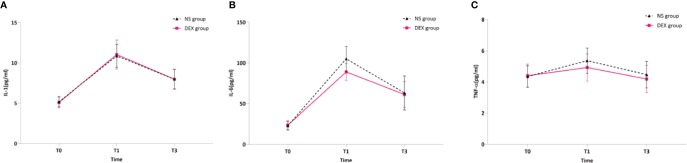
Changes in interleukin (IL)-1 (A), IL-6 (B), and tumor necrosis factor (TNF)-α (C) levels over time.